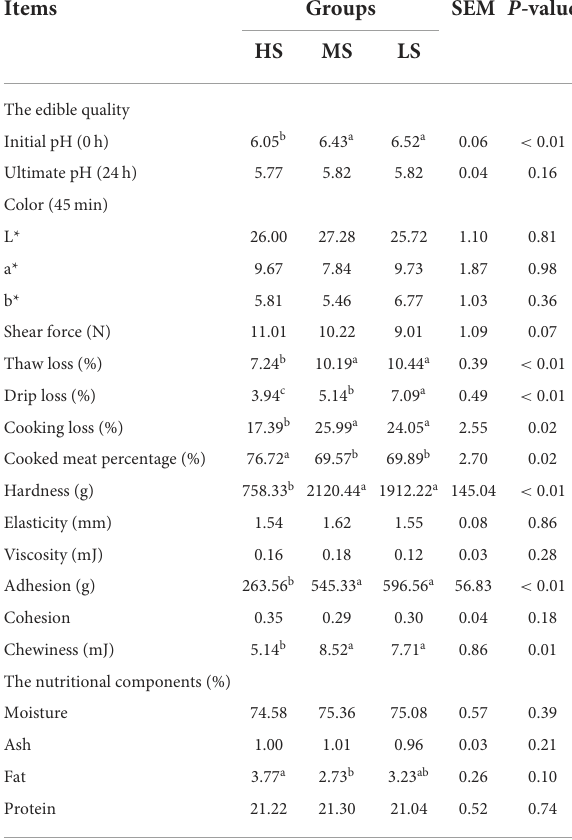
TABLE 3 Effect of different energy level diets on the edible quality and nutritional components of the longissimus lumborum of Tibetan